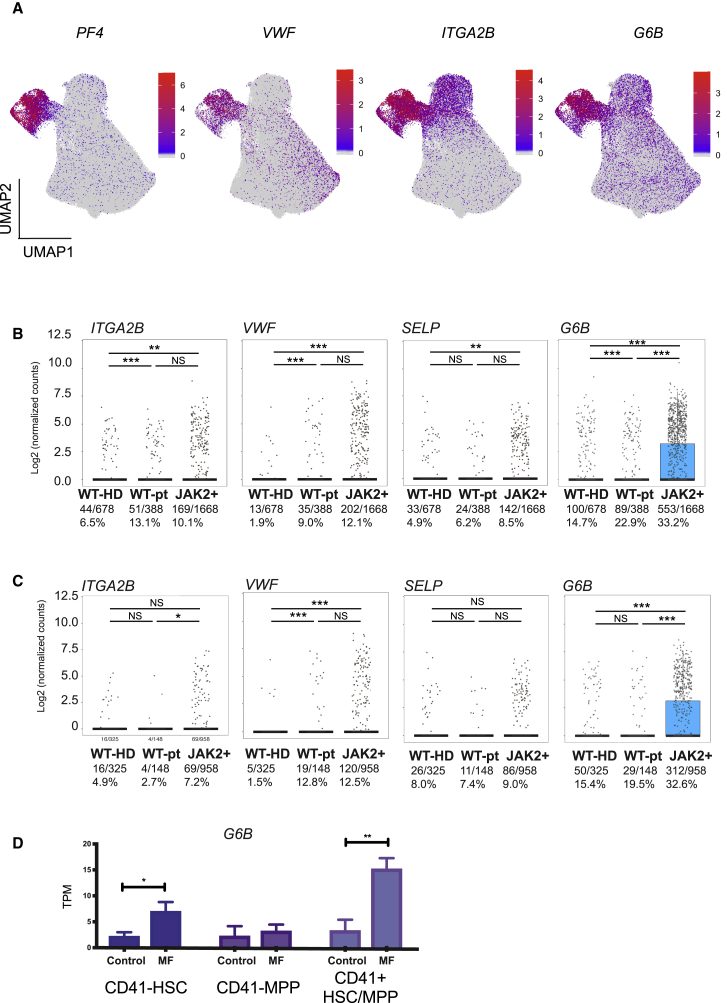
Increased Expression of Megakaryocyte-Associated Genes in Myelofibrosis Is Not Restricted to the MF-MkP Cluster but Is Substantially Higher in Cells Derived from the JAK2V617F+ Mutant Clone(A) Expression of intracellular (PF4 and VWF) and cell surface (ITGA2B [CD41] and G6B) megakaryocyte genes is not limited to myelofibrosis MkPs, particularly for G6B.(B and C) Simultaneous targeted mutational profiling and RNA sequencing (TARGET-seq) of 2,734 individual CD34+ Lin− HSPCs (B) and CD38-negative stem cells (C) identified by index sorting data show higher expression of megakaryocyte-associated genes ITGA2B (CD41), VWF, SELP, and G6B in JAK2V617F-mutated (JAK2+) versus wild-type cells from the same patients (WT-pt) or age-matched healthy donor control HSPCs (WT-HD). Fraction and % of cells in which gene expression were detected and are shown. The combined p value for Fisher’s exact test and Wilcoxon rank-sum test is shown (∗p < 0.05, ∗∗p ≤ 0.01, ∗∗∗p ≤ 0.001). Points represent expression values for each single cell, and boxes represent median and quartiles for each group.(D) G6B expression in bulk-sorted control and myelofibrosis immunophenotypic HSC (CD34+ lin− CD38−CD45RA−CD90+), MPP (CD34+ lin− CD38−CD45RA−CD90−), and CD41+ HSC/MPP (CD34+ lin− CD38-CD45RA− CD41+).TPM, transcripts per million. Chart shows mean ± SEM, n = 4 for controls and n = 3 for myelofibrosis; ∗p < 0.05; ∗∗p ≤ 0.01. See also Figure S6.